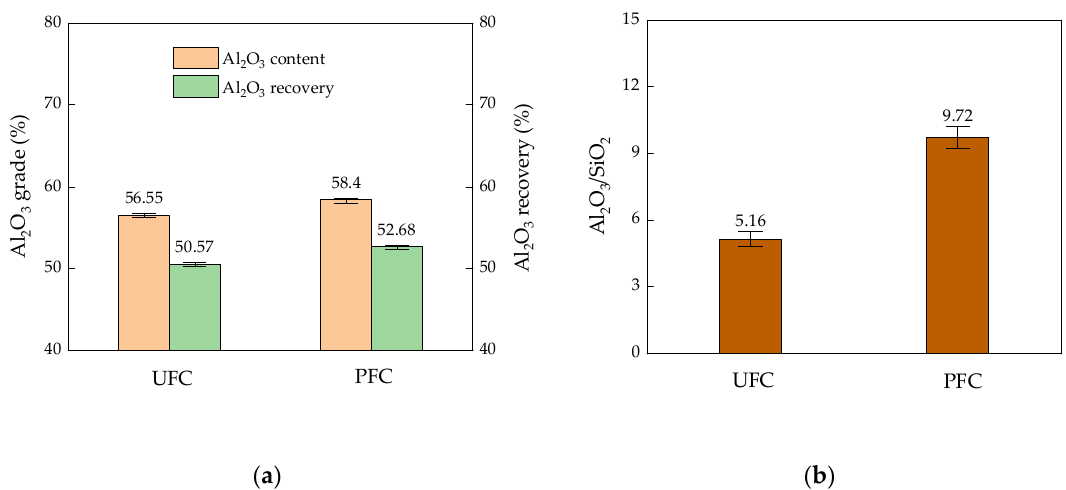
Figure 3. Flotation concentrate obtained by using unpacked flotation column (UFC) and plate-packed flotation column (PFC): ( a ) Al 2 O 3 grade and recovery; ( b ) Al 2 O 3 /SiO 2 ratio.